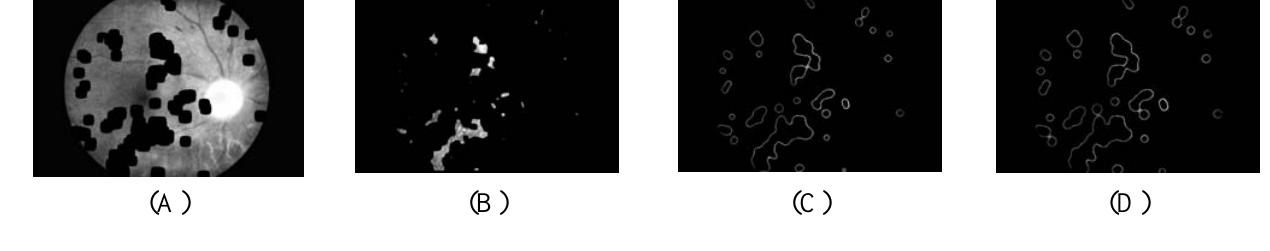
Figure 4. FCM clustering results with n=8. (A) Cluster 1. (B) Cluster 2. (C) Cluster 3. (D) Cluster 4. (E) Cluster 5. (F) Cluster 6. (G) Cluster 7. (H) Cluster